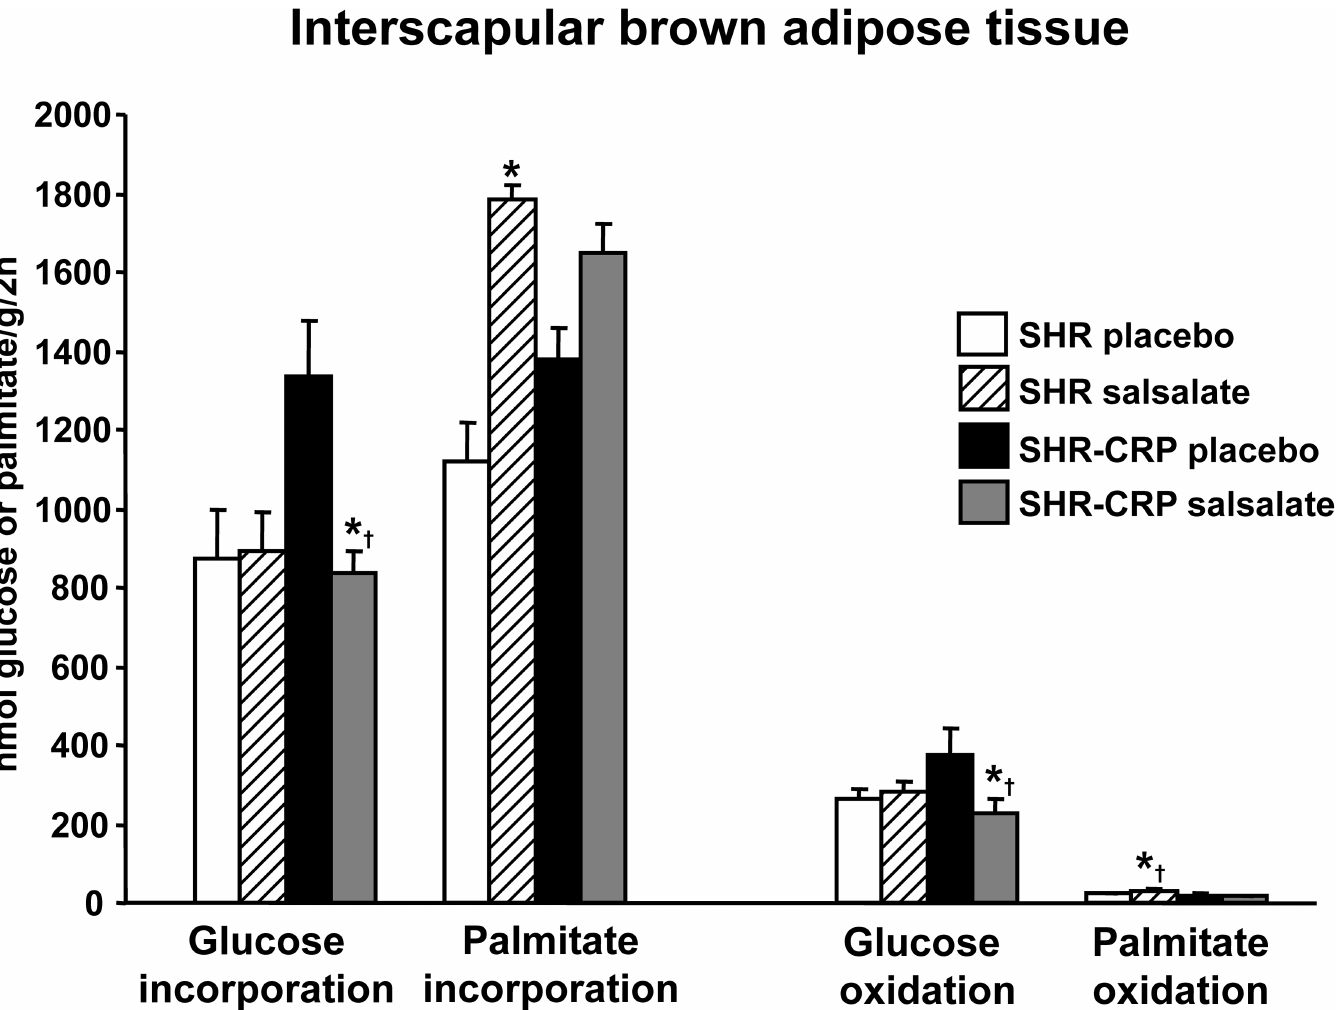
Fig 4. Glucose and palmitate incorporation and oxidation into interscapular brown adipose tissue (BAT) in SHR and SHR-CRP transgenic rats treated with placebo or with salsalate. In nontransgenicSHR, salsalatetreatment was associatedwith increasedpalmitateoxidationand incorporation into BAT while no significantdifferences were observedin transgenicSHR-CRP strains after salsalatetreatment. On the other hand, SHR-CRP rats treated with placebohad significantly higherglucose oxidationand incorporation into BAT when comparedto both SHR-CRP rats treated with salsalateand SHR rats treated with placeboor salsalate. * denotessignificantdifferences(P < 0.05)betweenplaceboversus salsalate-treated groups; † denotessignificantstrain x treatment interactions, i.e. salsalatetreatment in the presenceof human CRP (in SHR-CRP rats) suppresses glucoseoxidationand incorporation into BAT lipids, and increasespalmitateoxidationin the absenceof humanCRP (in SHR controls).